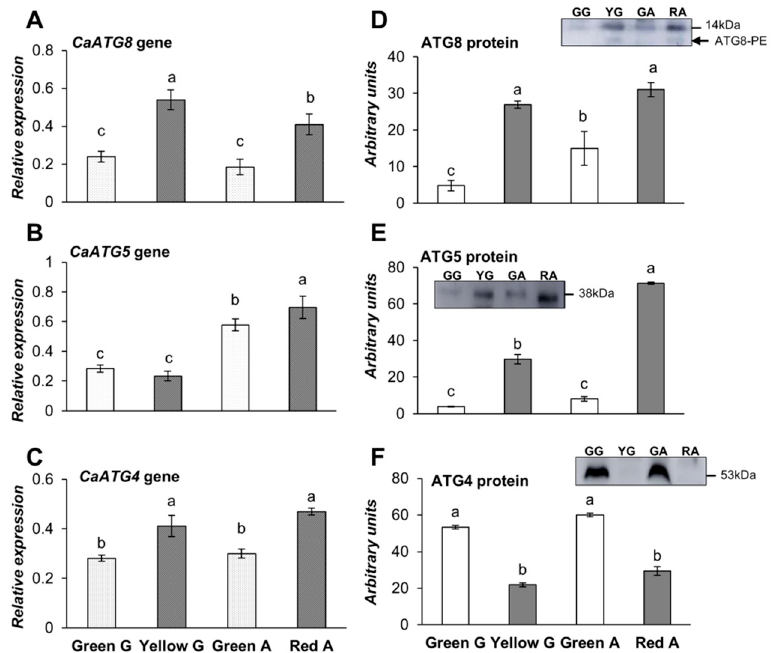
Figure 2. Expression analysis of ( A ) CaATG8a gene ( B ) CaATG5 gene and ( C ) CaATG4 gene relative to ACTINE-100 by RT-qPCR; Western blot analysis of the ( D ) CaATG8 (14 kDa protein; arrow points the lipidated phosphatidylethanolamine: PE form), ( E ) CaATG5 and ( F ) CaATG4 proteins in green Galena (GG), yellow Galena (YG), green Alonso (GA), and red Alonso (RA) pepper fruits. Data are means ± standard error (SE) of three technical replicates of three biological samples. Different lower case letters indicate that data are significantly different according to the Kruskal-Wallis test at p < 0.05.